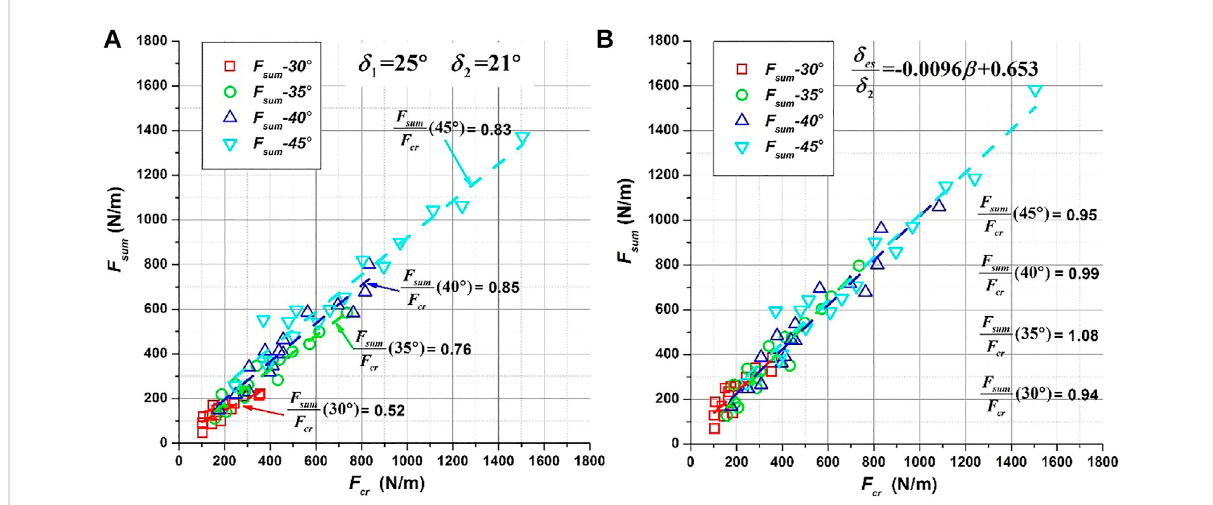
FIGURE 7 Comparison of calculated normal force of dynamic phase ( F sum ) with normal force of experimental measurement ( F cr ).